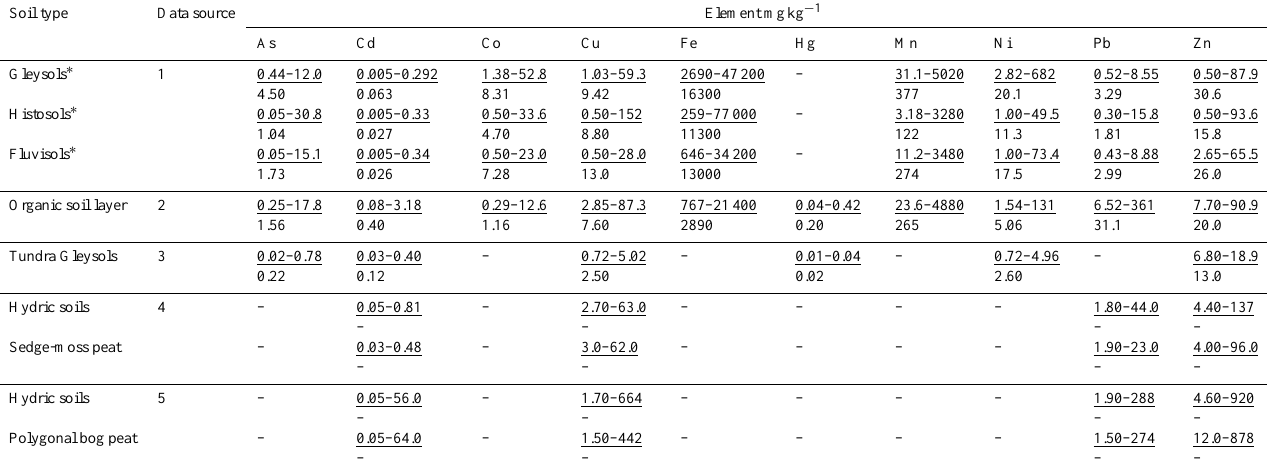
Table 5. Range (min–max) (numerator) and median values (denominator) of the trace metal concentrations reported for soil types of the eastern Barents region, the Baltic region, the lower Lena River area, north-eastern Siberia, and western Siberia.